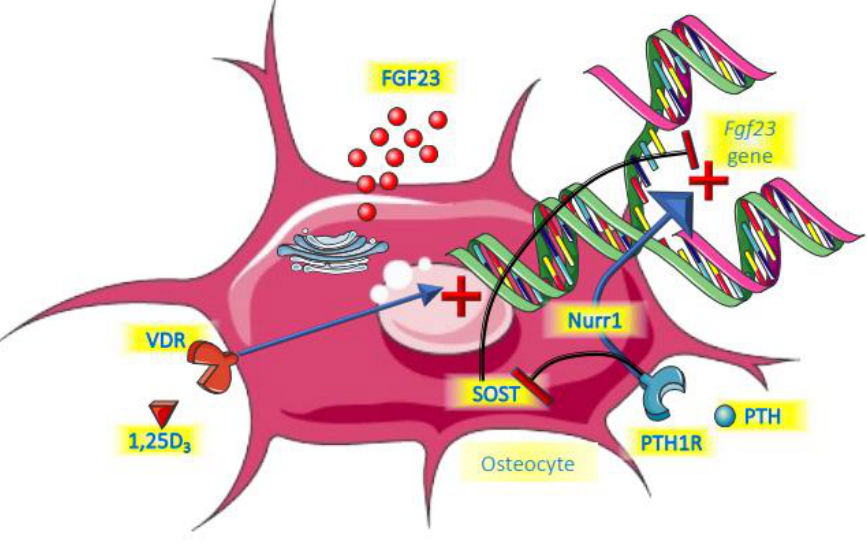
Figure 2. Endocrine control of